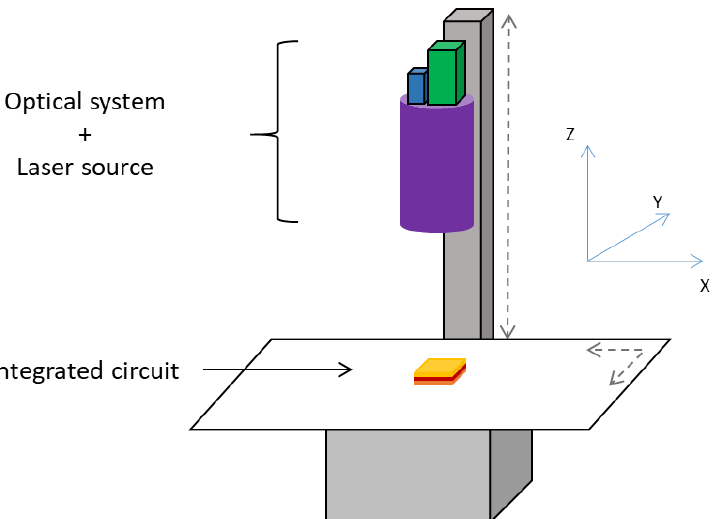
Figure 3. Representation of a bench used for laser-injection-based IC characterization. Each 3D scanning axis is motorized in the 3D XYZ coordinate system. The vertical column represents the Z axis, along which the optical system moves thanks to a motor. The horizontal tray, where the IC is placed, is motorized according to the XY